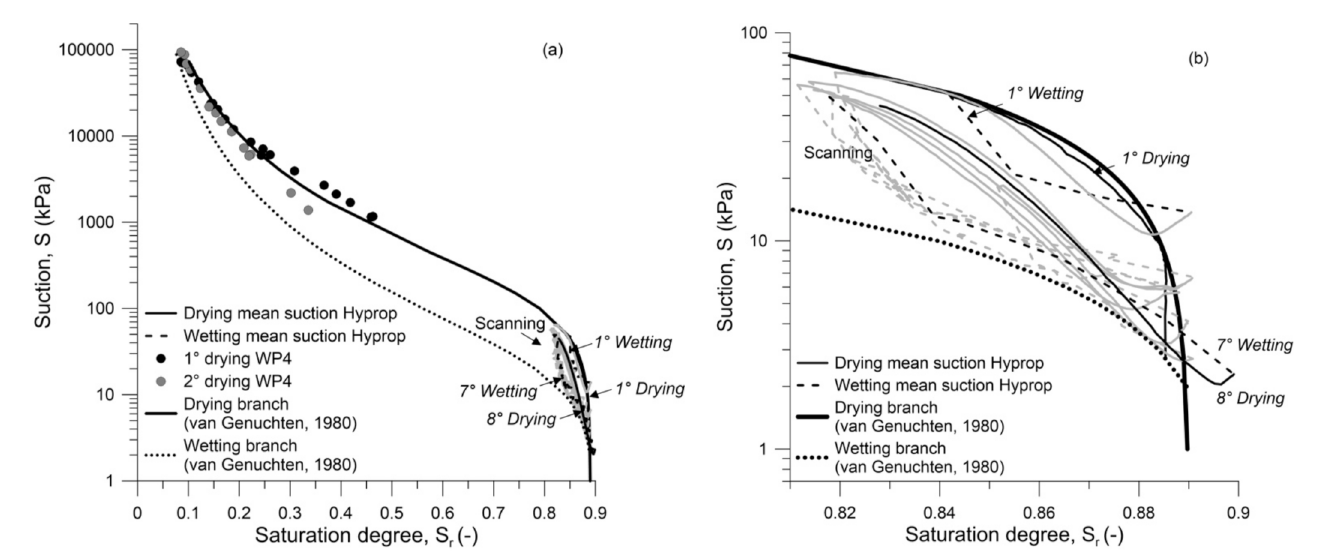
Figure 8. Drying and wetting branches of the water retention domain, as elaborated from the Hyprop data in Figure 7 on a sample of dyke silty material: ( a ) full suction range, and ( b ) 0 < S < 100